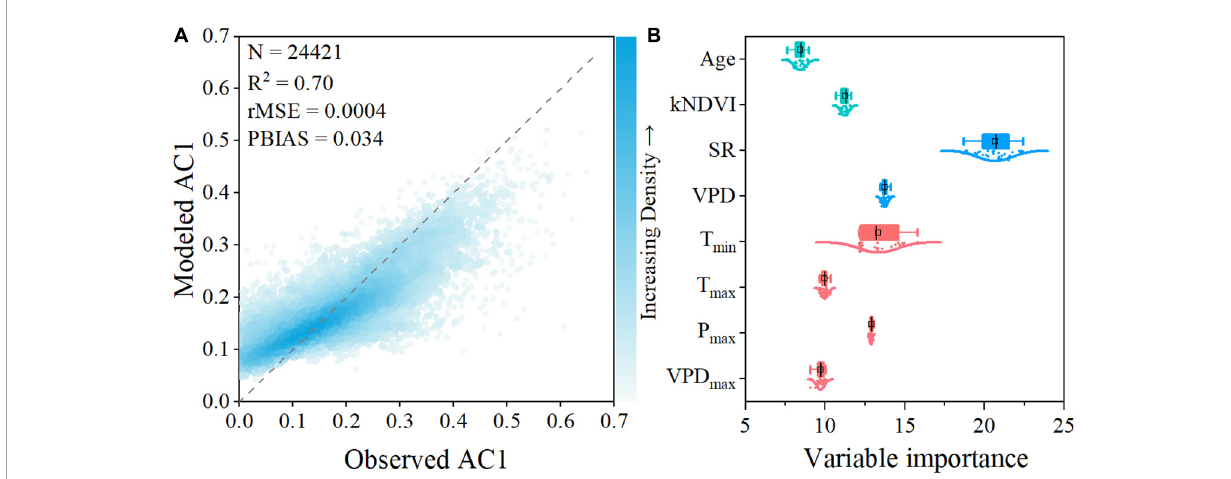
FIGURE4 Model performance and variable importance of the selected variables for explaining the spatial long-term AC1 using a random forest regression model. (A) Comparison between measured AC1 and modeled AC1. (B) Variable importance of the predictor variables within the RF regression model. Variable importance is quantified by the increase in mean square error (%IncMSE).